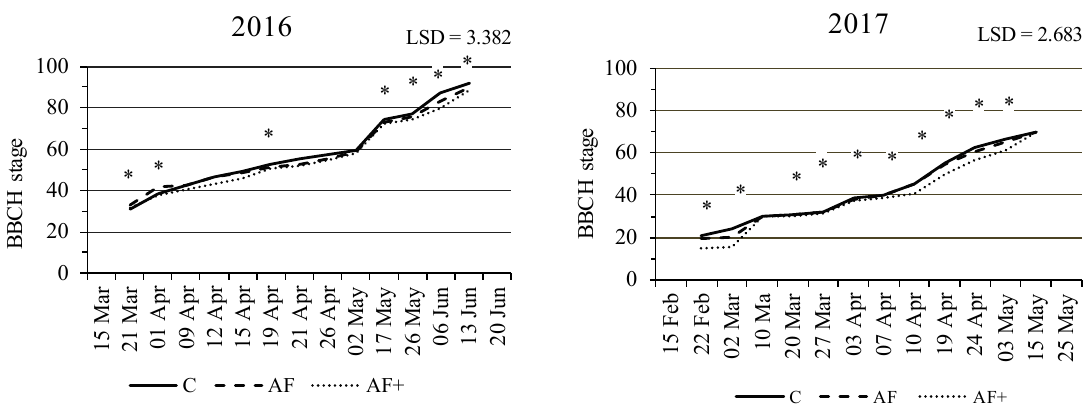
Figure 1. Phenological stages (BBCH ( Badische Anilin- und Soda Fabrik (BASF), Bayer, Ciba-Geigy, and Hoechst) scale; [24]) of durum wheat grown in the three treatments as the average of 25 varieties in the 2016 and 2017 growing seasons. The least significant difference (LSD) for the interaction “date × treatment” ( p ≤ 0.05). Asterisks indicate significant differences between treatments at each date (Tukey’s HSD test, p ≤ 0.05). C: controls, AF: pruned olive trees, AF+: un-pruned olive trees.